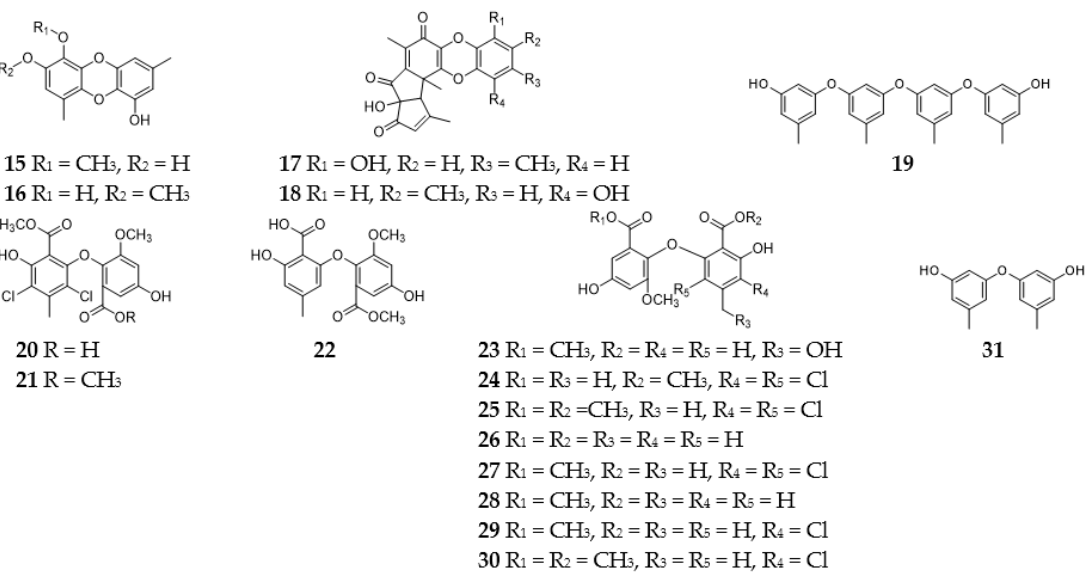
Figure 2. Aspergillus -derived diphenyl ethers ( 15 – 3 1 ).